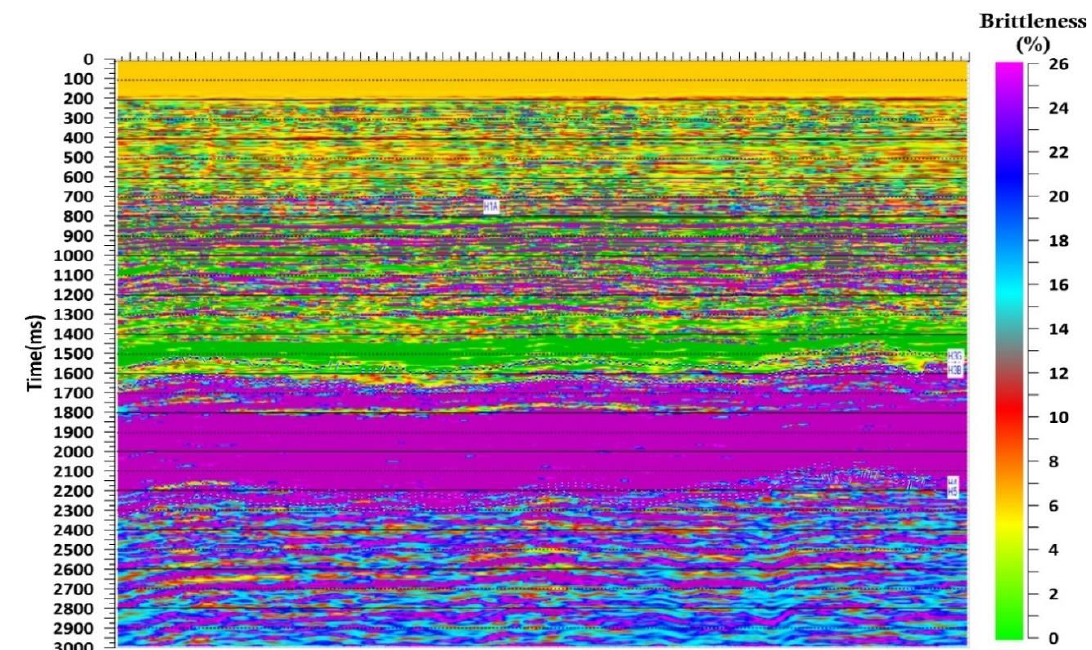
Figure 9. Illustrates the brittleness index computed from the seismic data after inversion ranges from 3- 40 % in the subsurface layers of the study